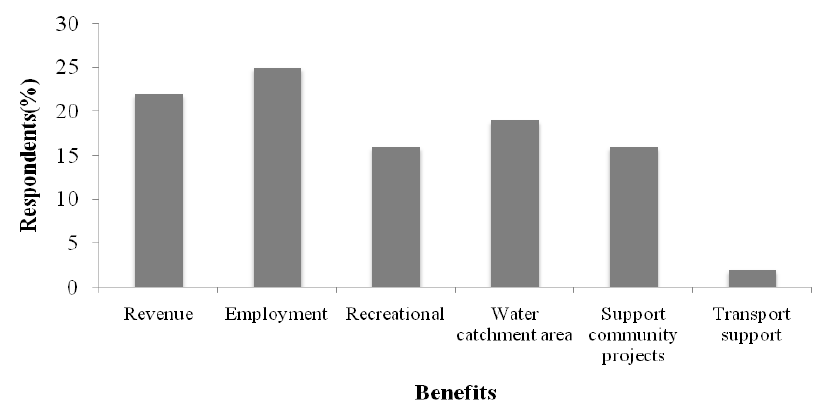
Fig. 2. Benefits of community participation in wildlife